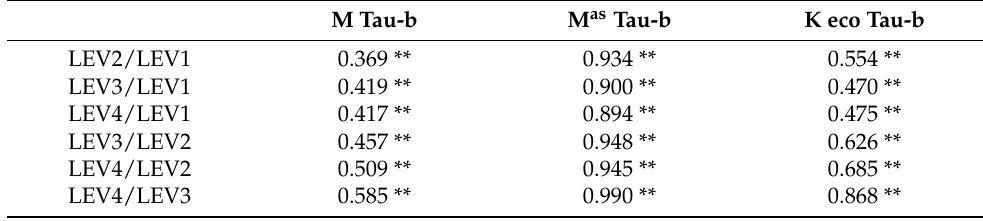
Table 1. Comparison between couples of scenarios at the Bio-Energy Landscape Unit (BELU)